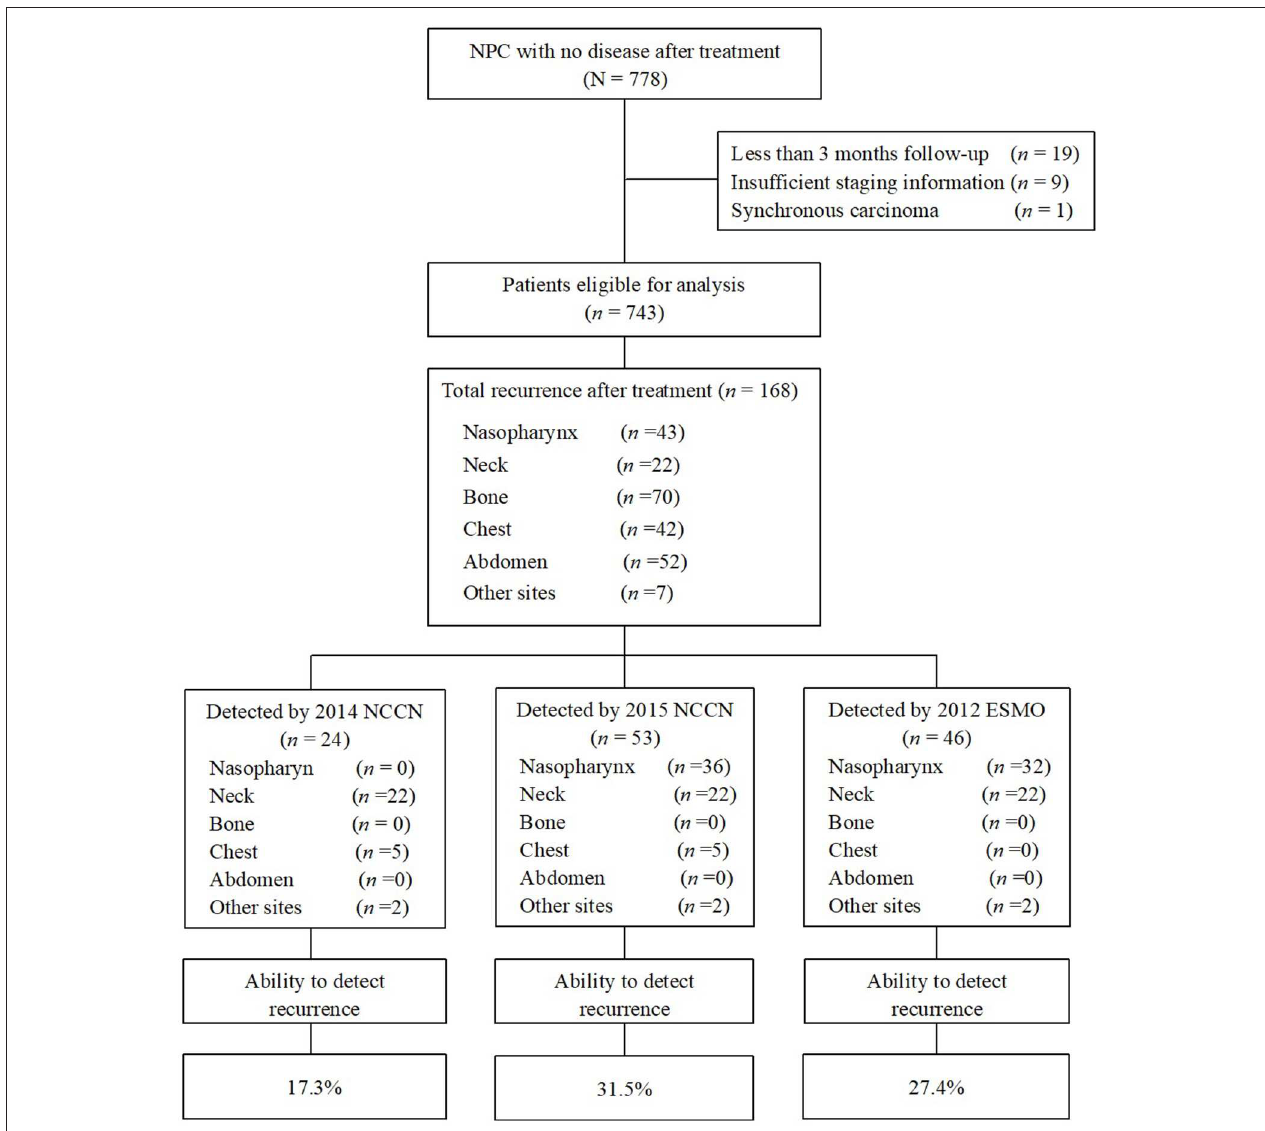
FIGURE 1 | Flowchart of patients enrolled in this study. Ability to detect recurrence (%) = recurrences detected if strictly follow the guidelines/the total number of recurrence after treatment × 100%. NPC, nasopharyngeal carcinoma; NCCN, National Comprehensive Cancer Network; ESMO, European Society for Medical